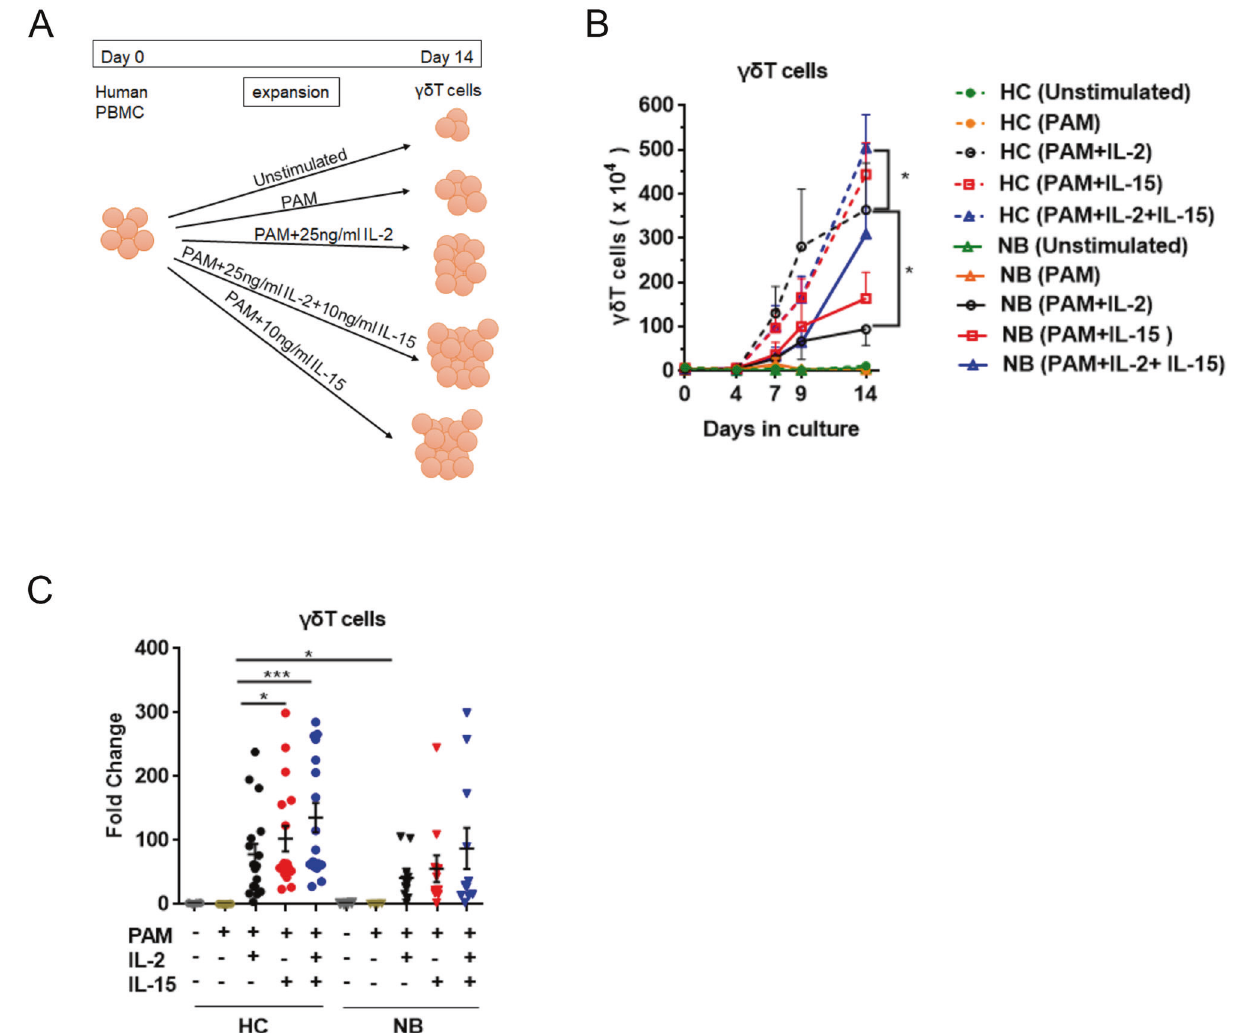
Fig. 2 Quali fi cation of γδ T-cell expansion capacity in vitro culture conditions. γδ T cells were stimulated with PAM supplemented with either IL-2 or IL-15 or both of them and expanded in vitro for 14 days. A Flowchart of the experimental setup to study in vitro γδ T-cell expansion capacity with different culture conditions. B At culture days 0, 4, 7, 9, and 14, the absolute numbers of γδ T cells from HC and NB were measured by fl ow cytometry (HC, n = 7; NB, n = 7). Data were mean ± SEM from four independent experiments. Statistical analysis was performed using one-way ANOVA and Dunnett ’ s multiple comparisons. *, p < 0.05. C fold change was calculated by dividing the number of γδ T cells on day 14 by the numbers of γδ T cells at the start (HC, n = 17; NB, n = 11). Data were mean ± SEM from fi ve independent experiments. Statistical analysis was performed using one-way ANOVA and Dunnett ’ s multiple comparisons. *, p < 0.05; ***, p <